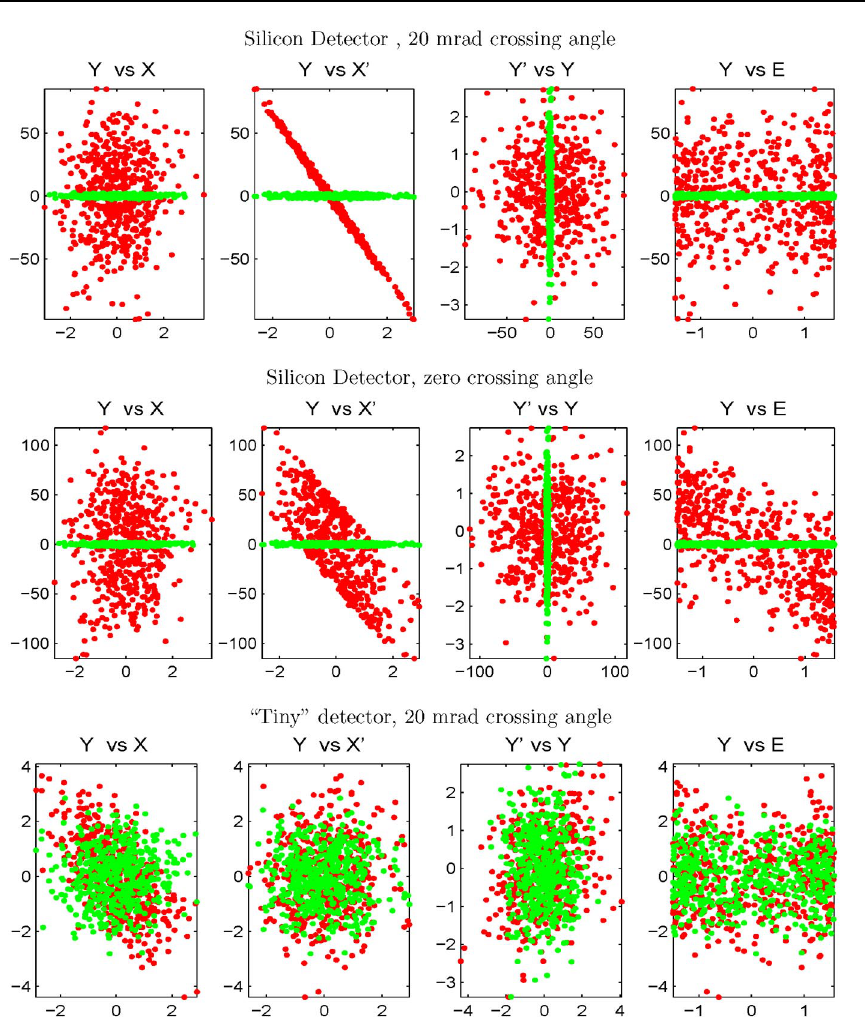
FIG. 5. (Color) Beam phase space at the IP obtained by tracking with two different detector solenoid models. Green dots show the ideal beam (no detector field); red, with detector solenoid field. Coordinates are normalized to the ideal beam sizes. No correction of the beam size was